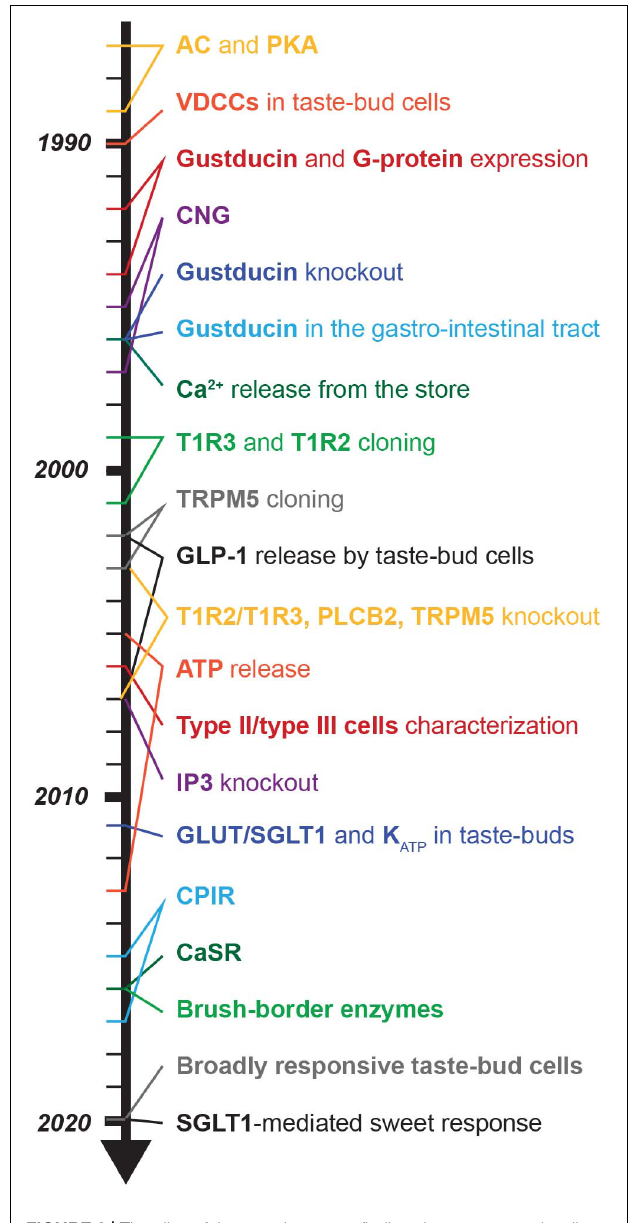
FIGURE 3 | Time-line of the most important findings in sweet taste signaling. The years of the most important publications are marked by lines. The scheme refers to findings related to sweet signaling transduction and focus mainly on the taste bud